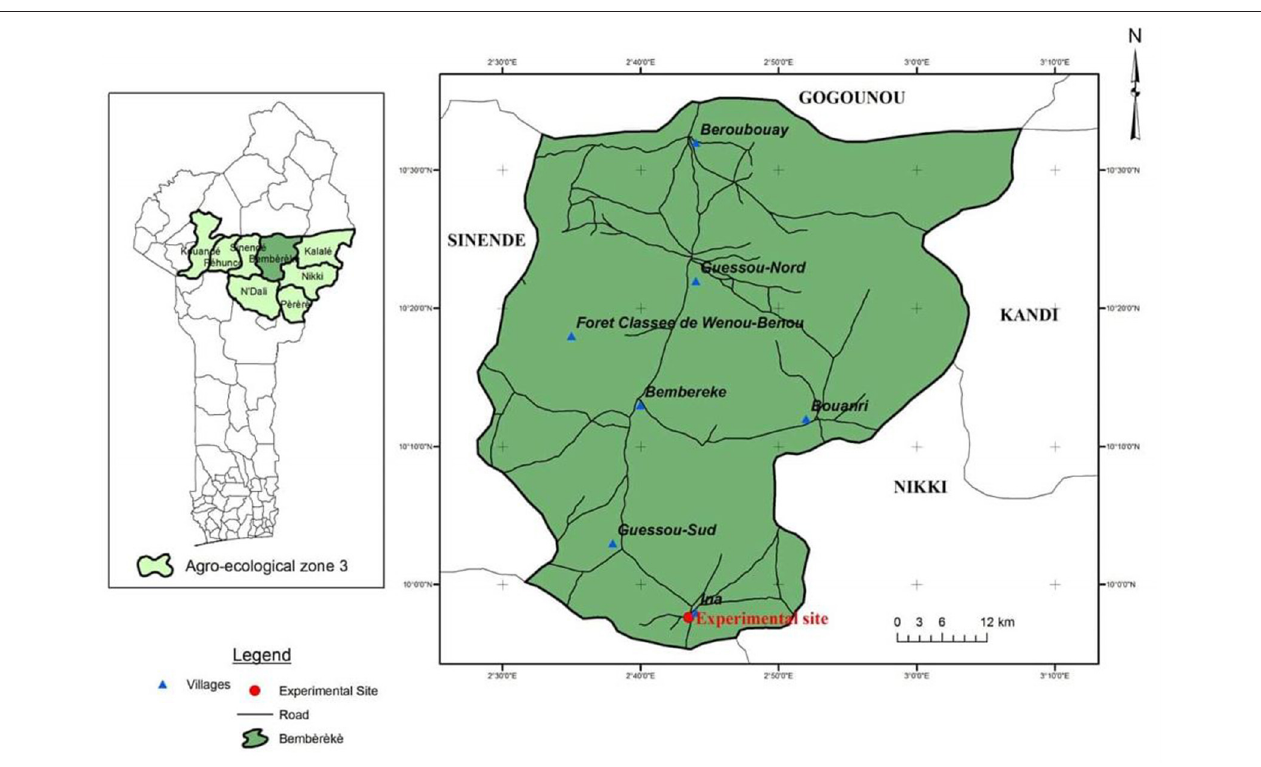
FIGURE 1 | Location of the experimental site.